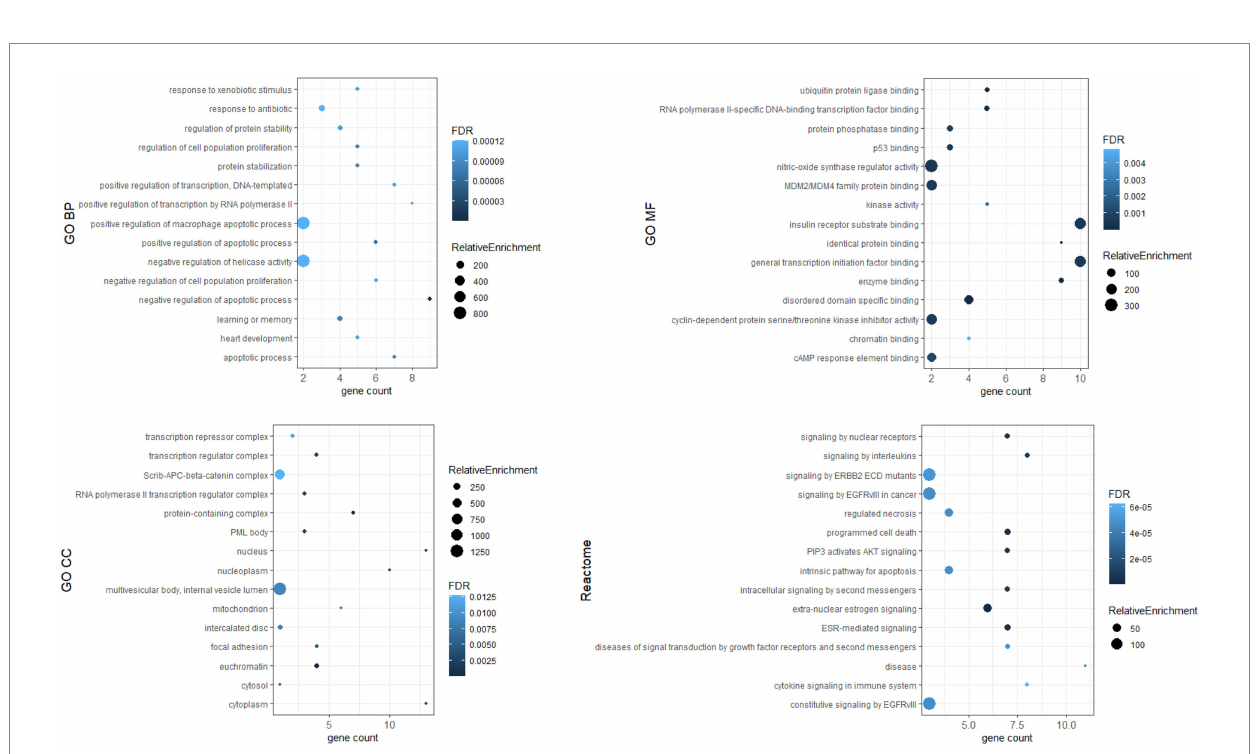
FIGURE 8 Top 15 terms for hub genes targeted by downregulated